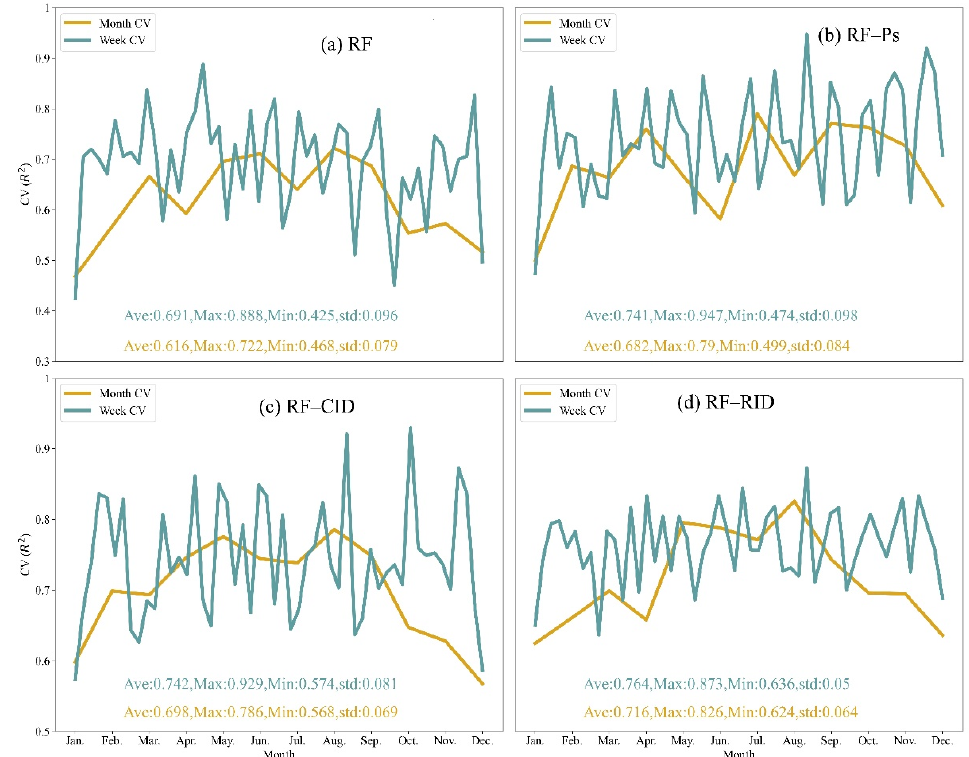
Figure 5. The CV of RF, RF–Ps, RF–CID and RF–RID for 7 consecutive days and 12 months. Fifty- two groups were validated for 7 consecutive days.